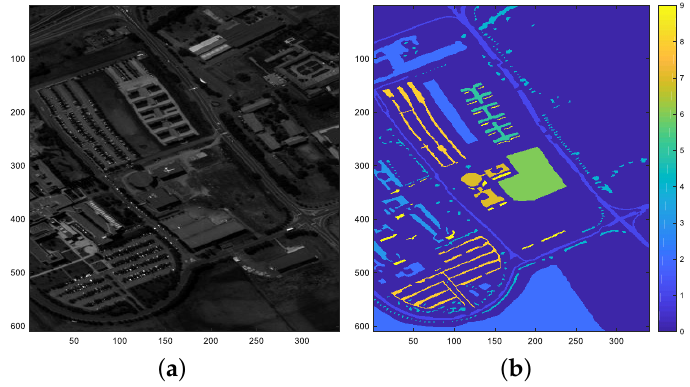
Figure 8. Band 50 and the ground truth of the Pavia University dataset. ( a ) Band 50. ( b ) The ground truth (label 0 denotes